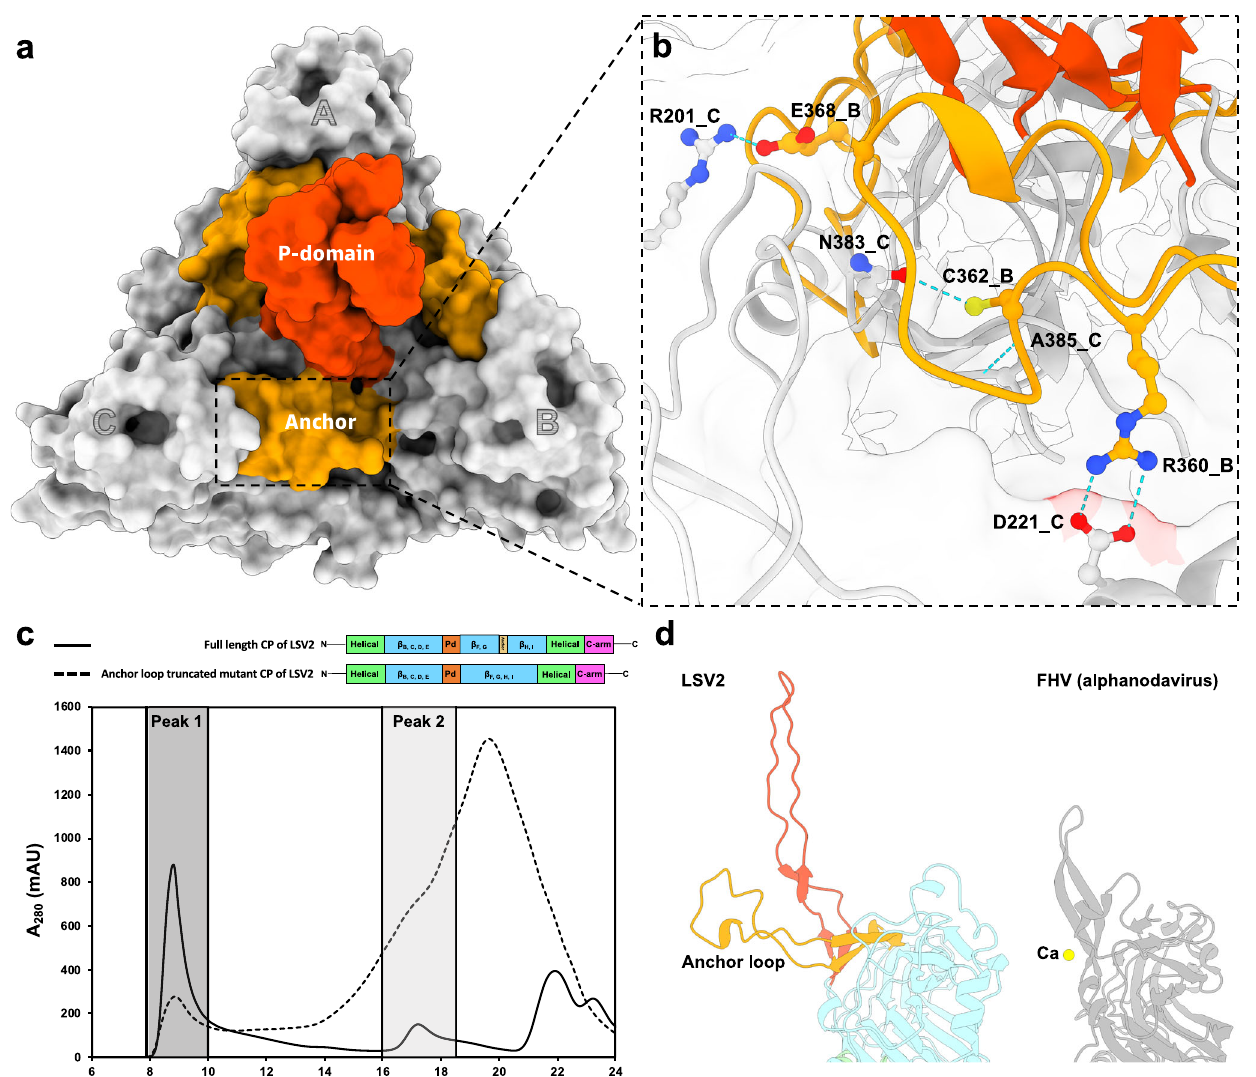
Fig. 2 | The P-domains and anchor loops form the homo-trimeric capsomere interfaces. a Surface presentation of one homo-trimeric capsomere on the T =4 LSV2 VLP. The P-domains and anchor loops are colored in salmon red and orange, respectively. b The chemical interactions at the interface between two subunits of one homo-trimeric capsomere. The hydrogen bonds are shown with the dotted blue lines. c The elution pro fi les of the full-length (solid line) and the anchor-loop- deletionmutant(dashline)ofLSV2VLPsinthesize-exclusionchromatography.The